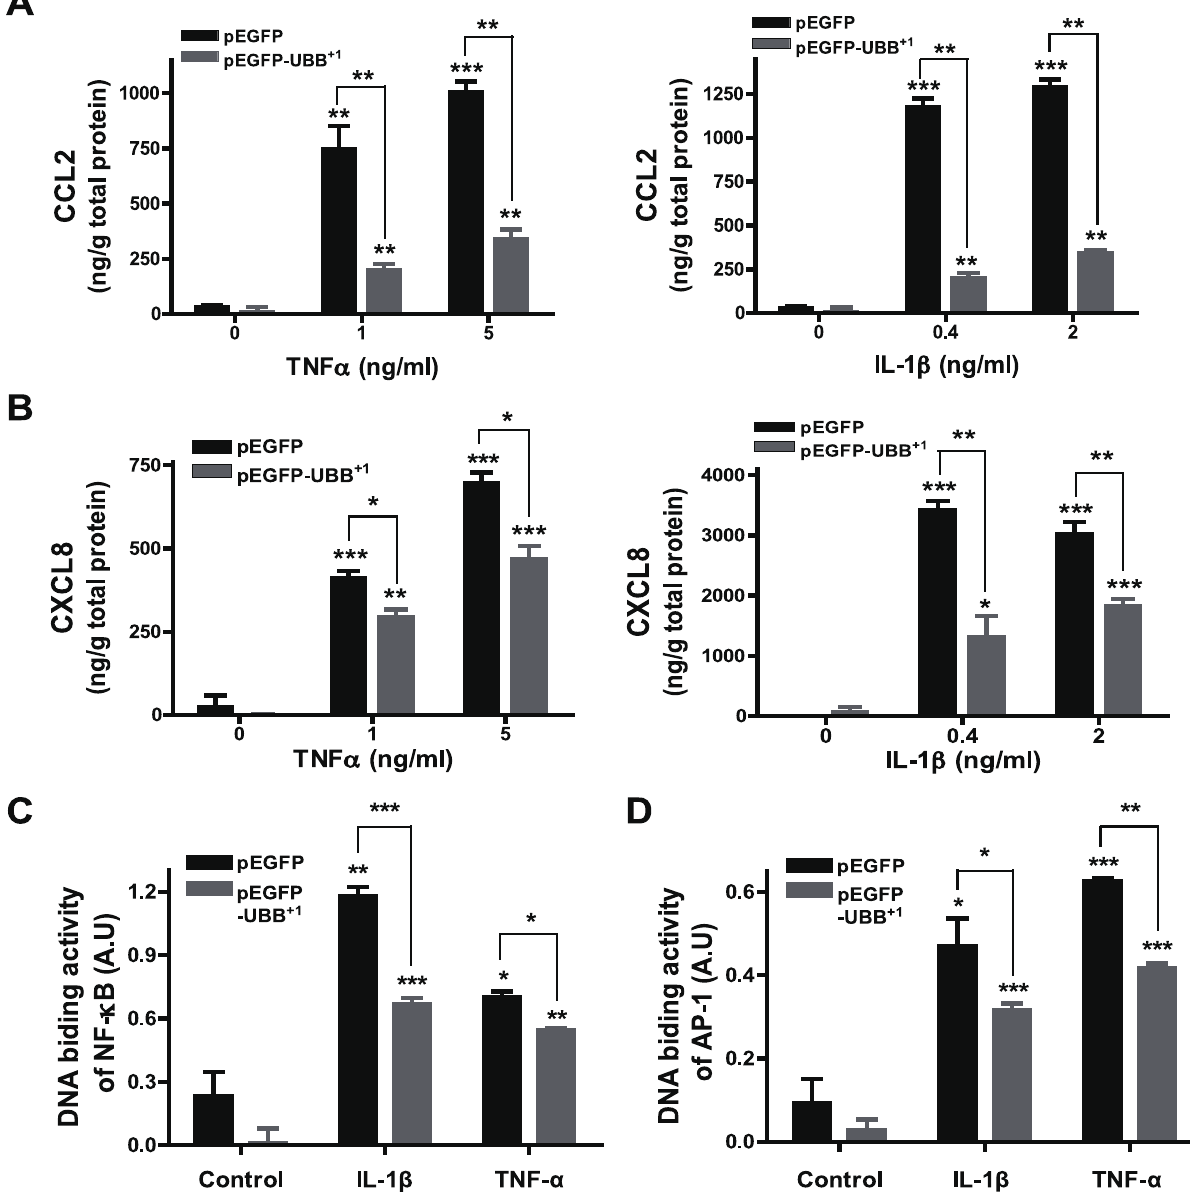
Figure 2. Effect of UBB + 1 on IL-1 b - and TNF- a -mediated chemokine expression. CRT-MG cells stably expressing pEGFP or pEGFP-UBB + 1 were treated with varying doses of TNF- a or IL-1 b for 24 h, and the supernatant was assayed for CCL-2 (A) or CXCL-8 (B) protein by ELISA. Control samples are the supernatants from the cells without any treatment. Representative of two independent experiments. Cells stably expressing pEGFP or pEGFP- UBB + 1 were treated with IL-1 b (4 m g/L) or TNF- a (10 m g/L) for 30 min, and then the nuclear extracts from cells were assayed for the binding activity of p65/c-Rel (NF- k B) (C) or c-Jun (AP-1) (D). Values statistically significantly different from the value for the control samples without any treatment are indicated by asterisks (*, p , 0.05; **, p , 0.01; and ***, p , 0.001). Representative of two independent